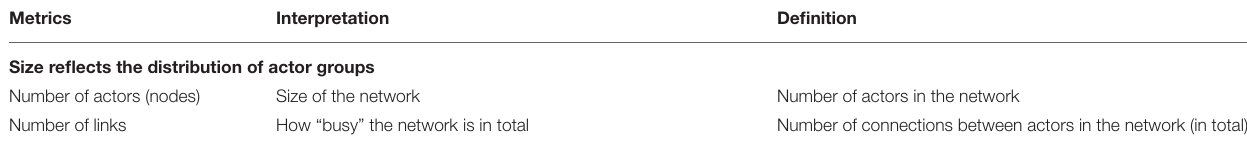
TABLE 4 | Social network metrics.